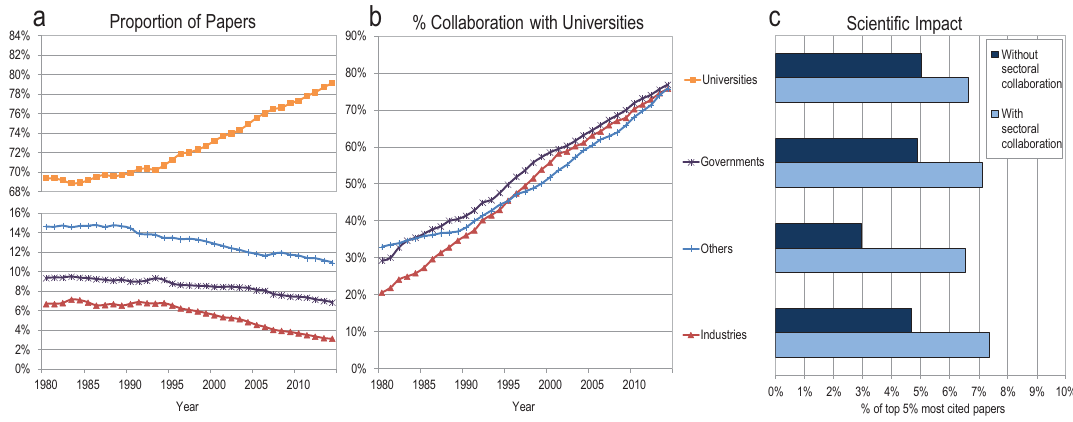
Fig 1. (A) Proportion of fractionalized papers, (B) proportion of papers written in collaboration with universities, and (C) scientific impact, by sector (world level), 1980–2014.